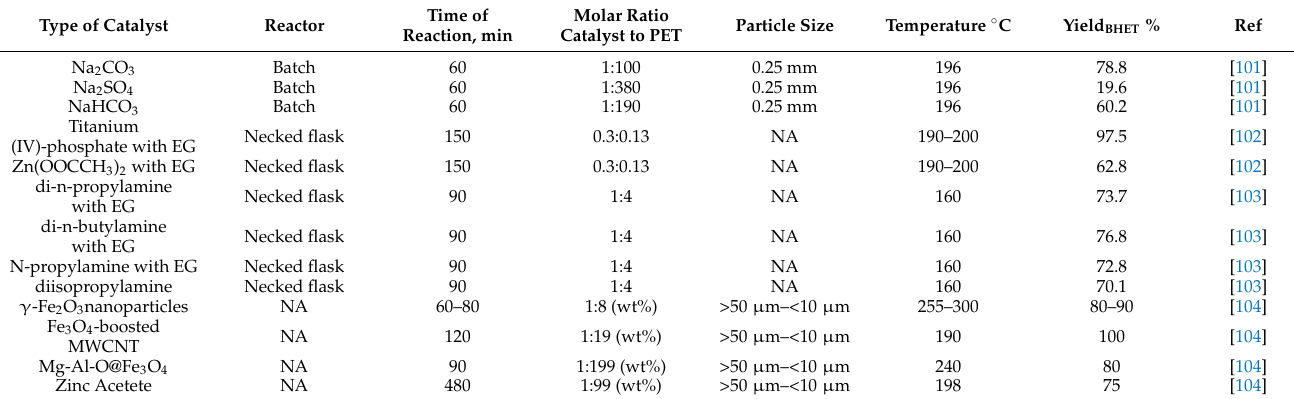
Table 2. The yield of BHET from PET glycolysis with different kinds of